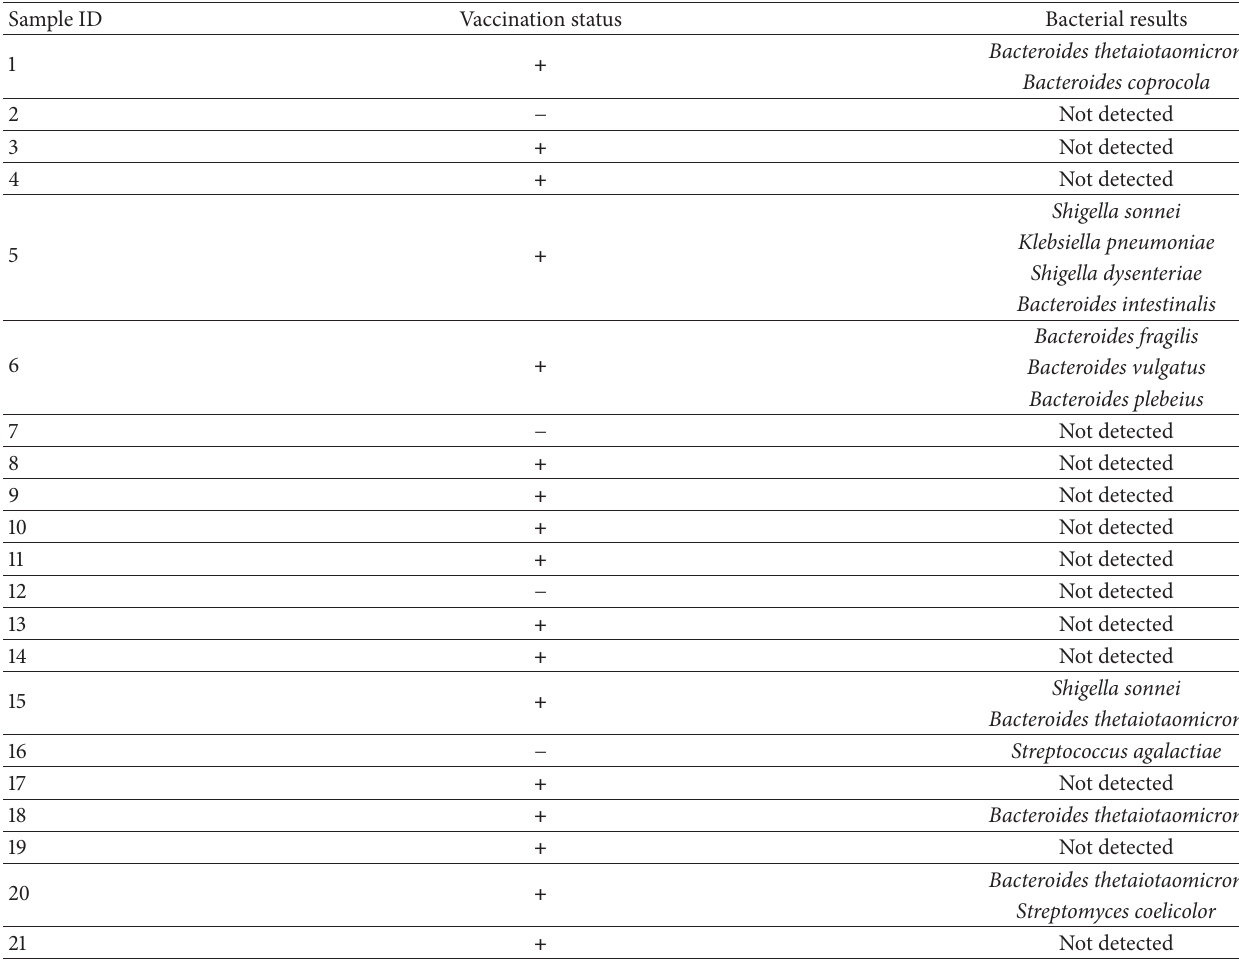
Table 4: Bacterial sequences detected from the human ileum samples by the LLMDA array. Microarray data was analyzed using the CliMax software as described [28]. (+, vaccinated; − ,